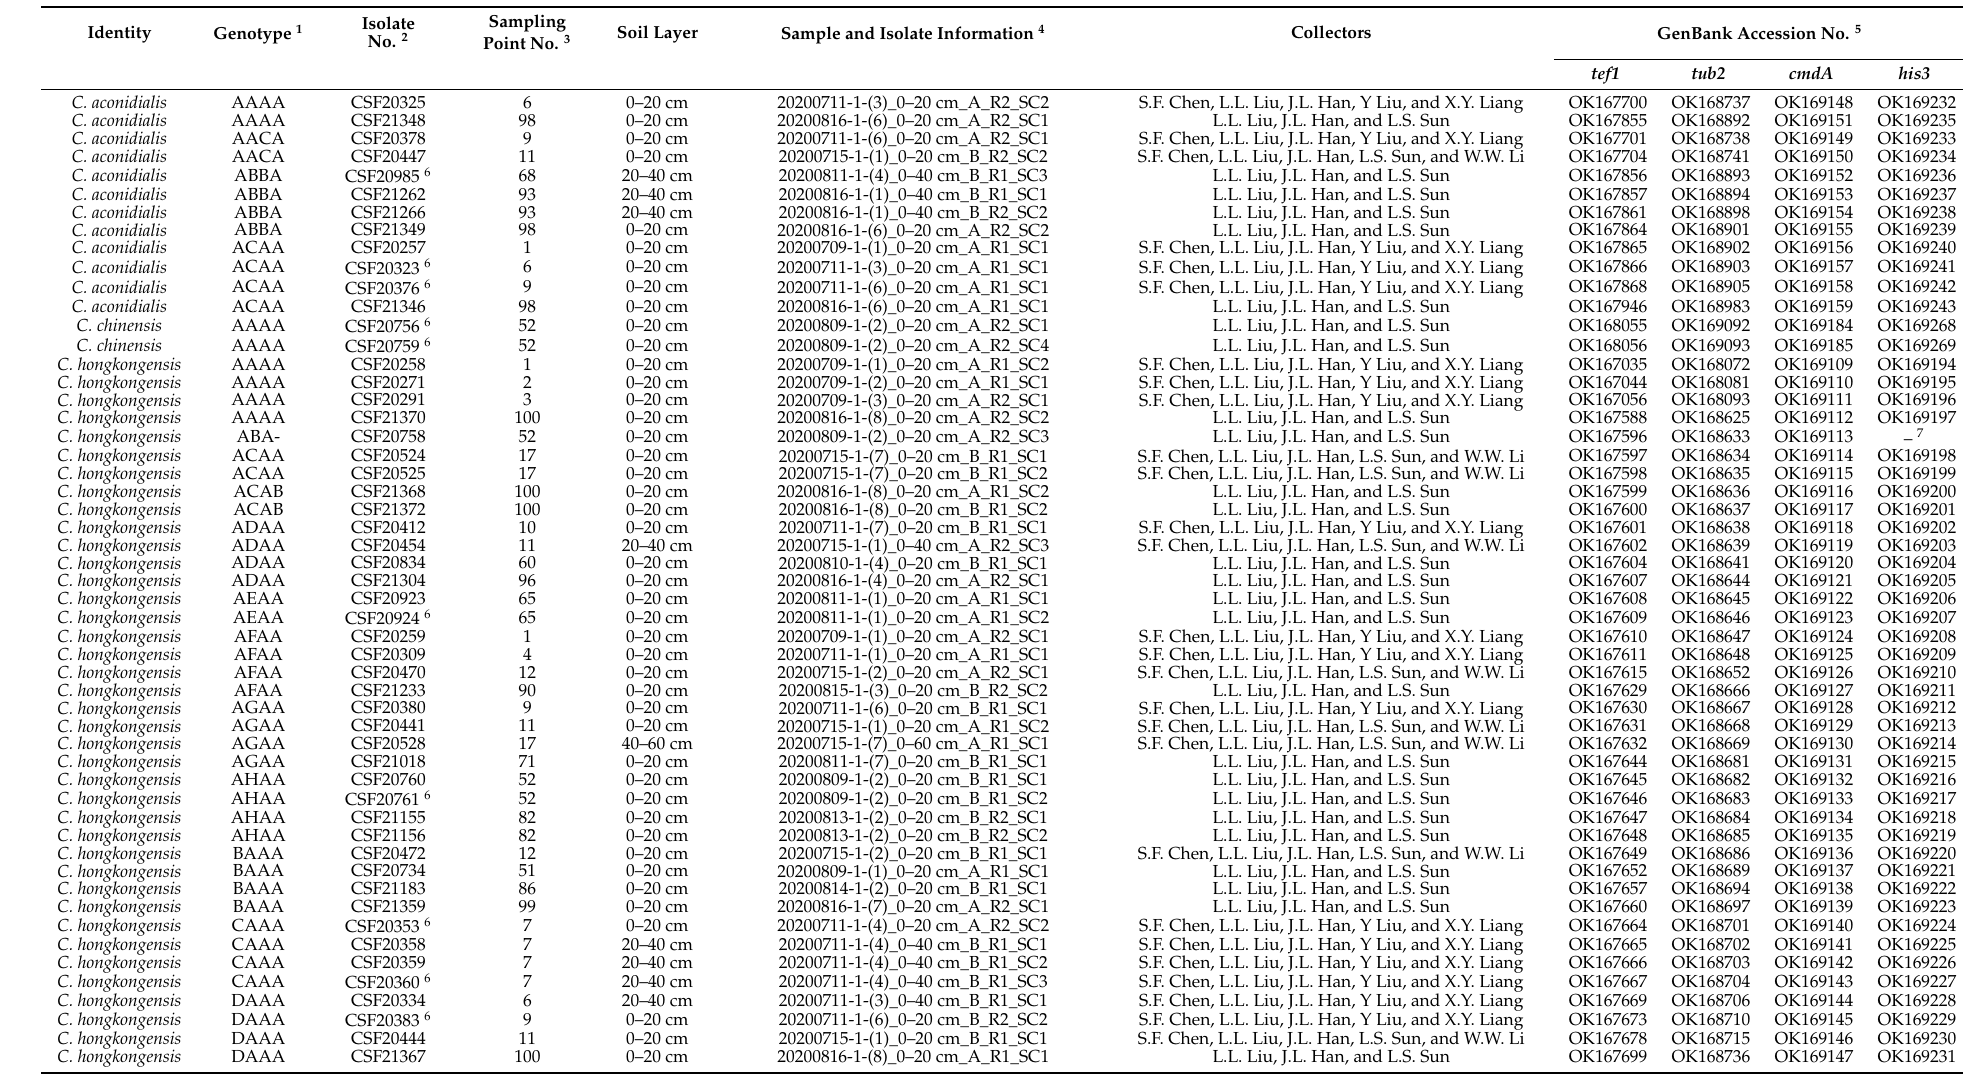
Table 3. Isolates sequenced and used for phylogenetic analyses and morphological studies in this